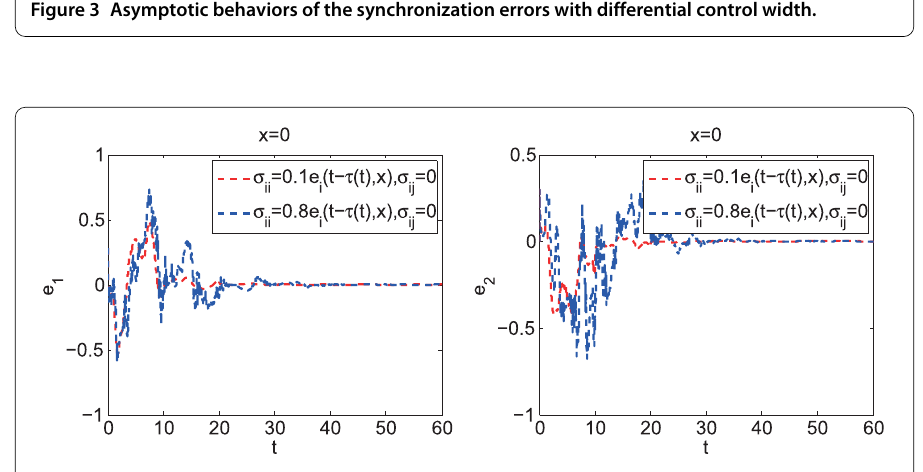
Figure 4 Asymptotic behaviors of the synchronization errors with differential stochastic perturbation.